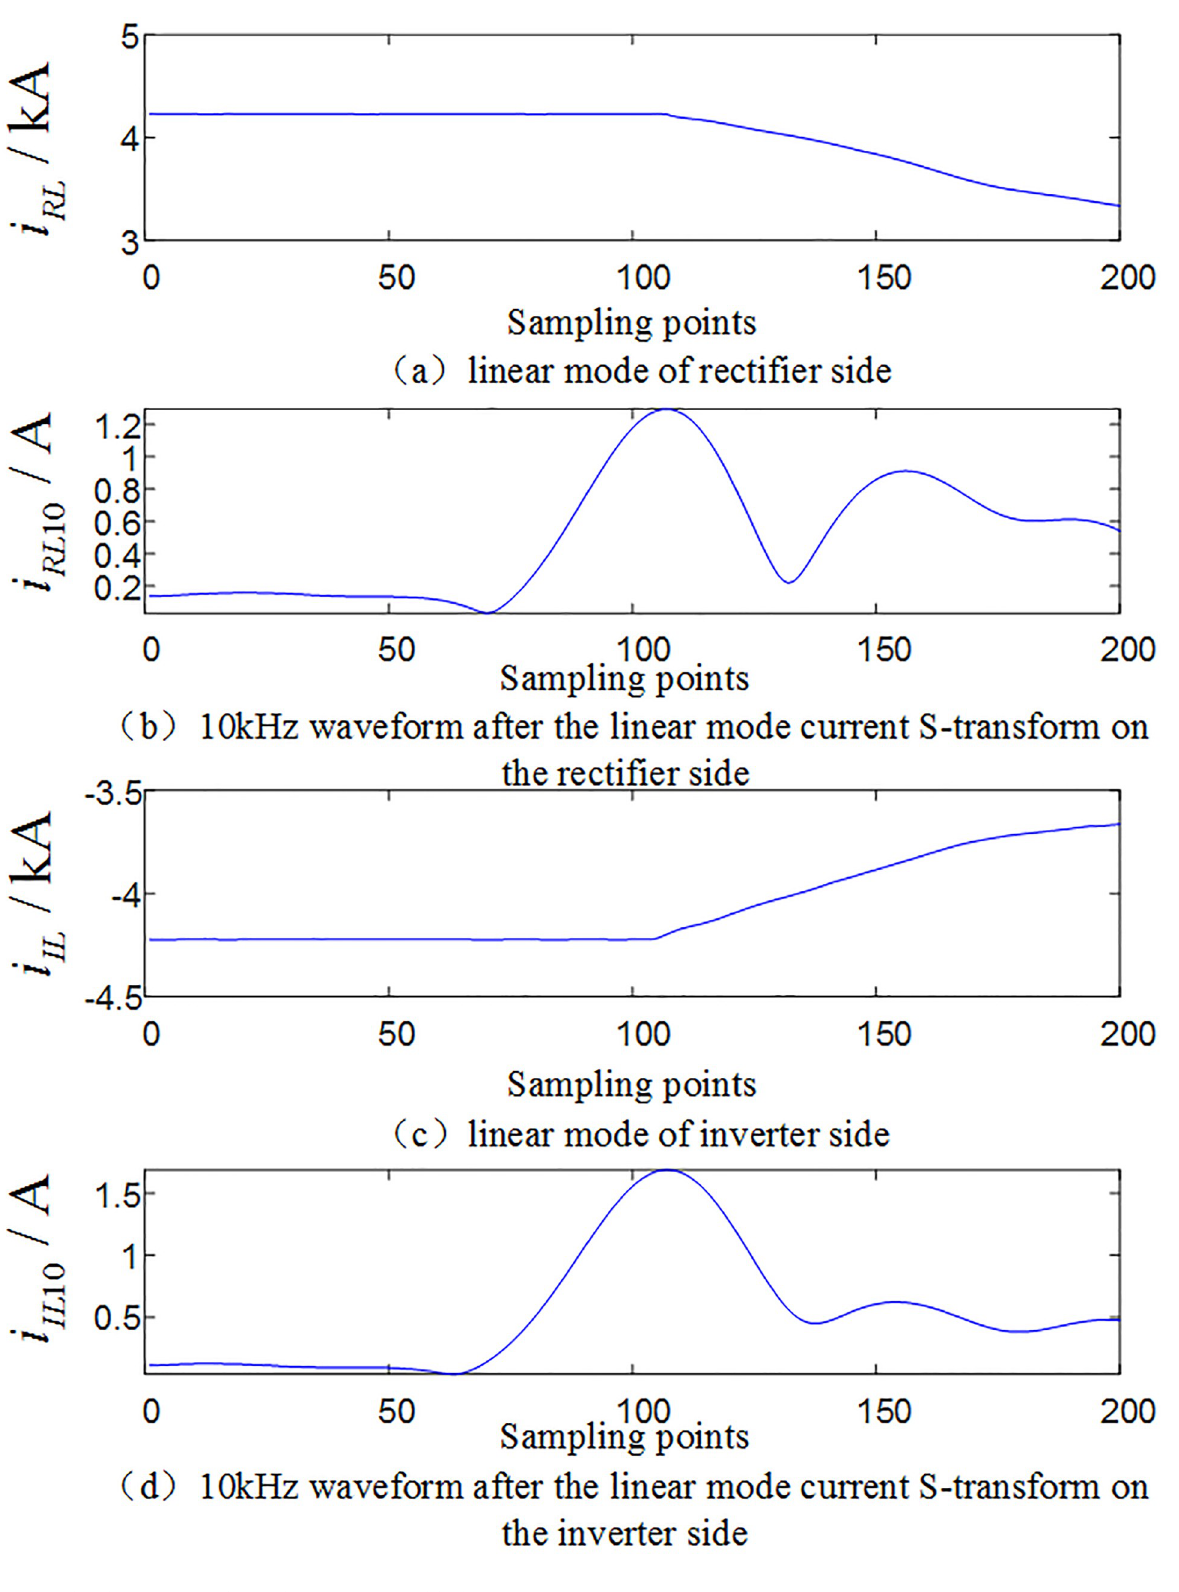
Fig 6. Related current waveforms during an external fault occurs. https://doi.org/10.1371/journal.pone.0230717.g006 PLOS ONE | https://doi.org/10.1371/journal.pone.0230717 March 26,